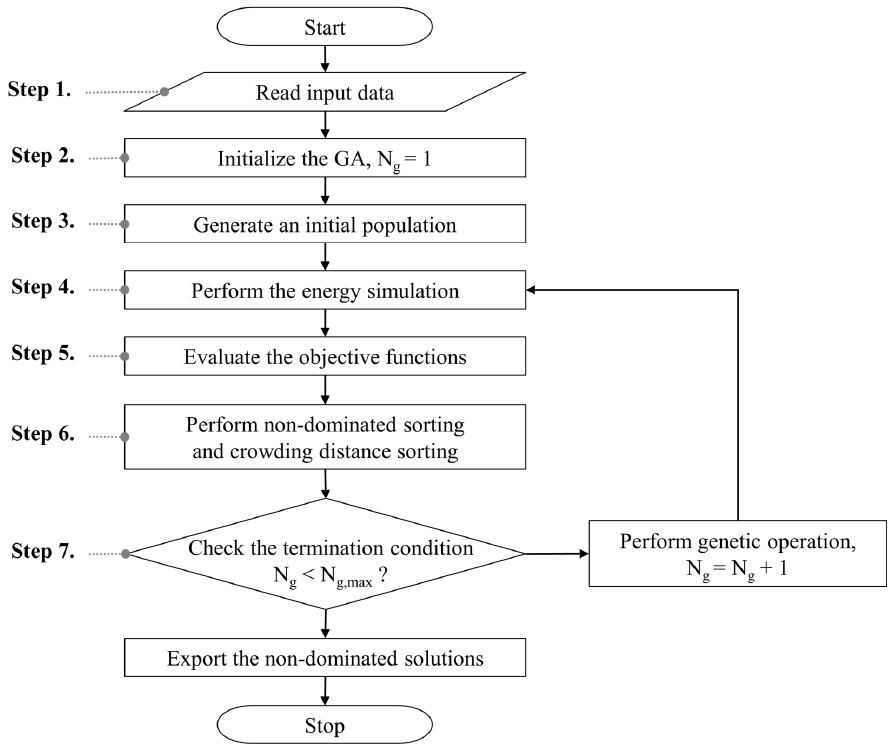
Figure 2. Flowchart of proposed multi ‐ objective optimization algorithm.